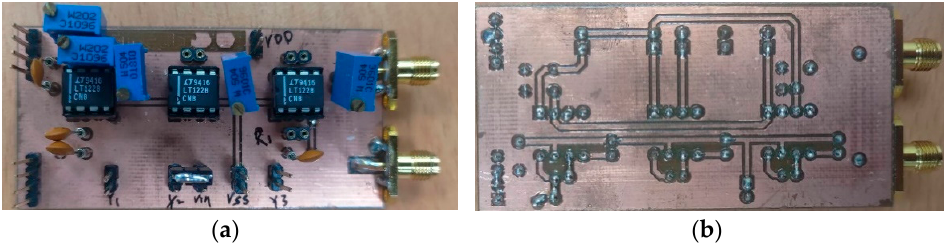
Figure 5. The ( a ) top view and ( b ) bottom view of the measured prototype from Figure